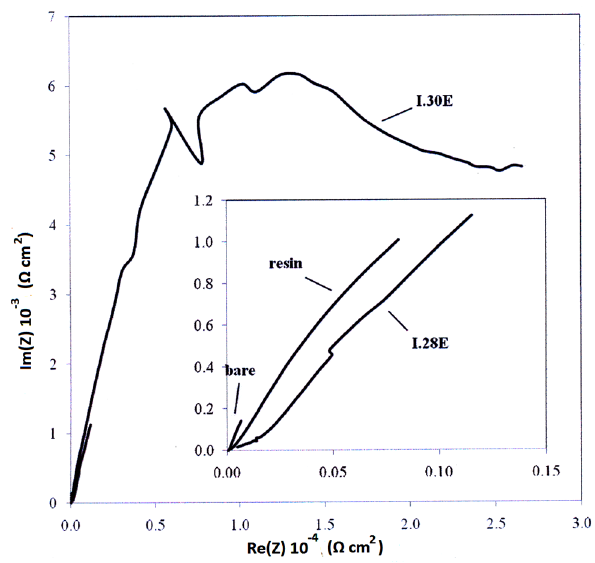
Figure 15. Nyquist plots of impedance spectra, R e (Z), real part of impedance, and I m (Z), imaginary part of impedance, for bare and coated specimens after 1 day of exposure in a corrosive environment of 3.5 wt % NaCl solution.